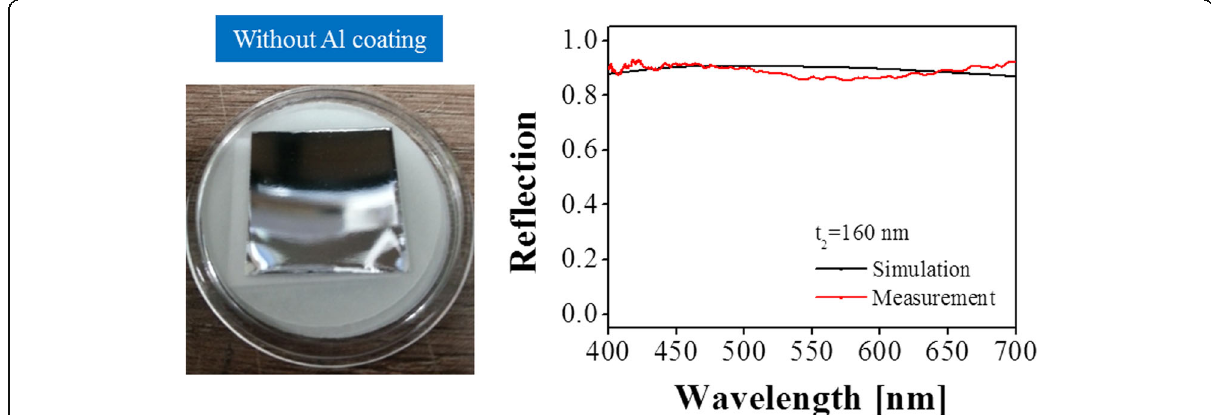
Fig. 8 Captured optical color image of the simulated and measured reflection spectra of the reference structure with no Al coating layer on top of the NAA